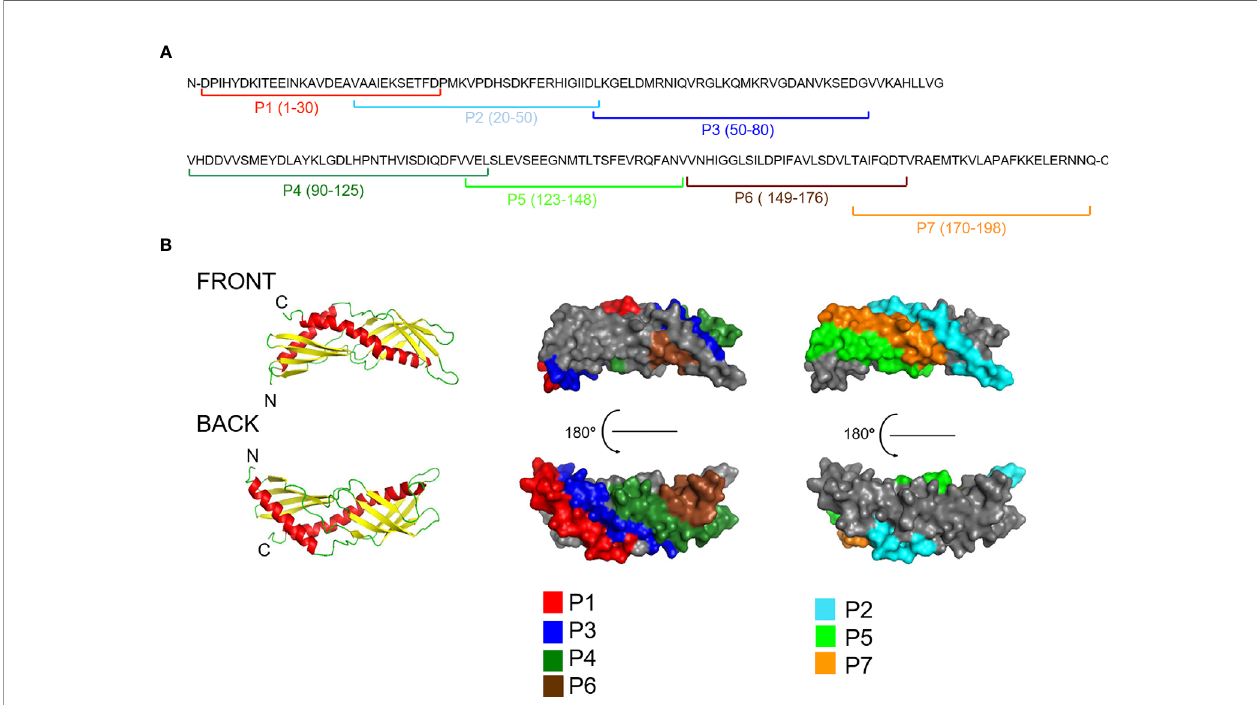
FIGURE 2 | Visualization of peptides spanning the Der p 7 sequence in the Der p 7 structure (A) The position of the peptides is indicated in the Der p 7 amino acid sequence (P1-7). (B) Visualization of the peptides in a model of the 3-dimensional structure of Der p 7 created according to the crystal structure (PDB: 3H4Z). Left images: Ribbon representations of the Der p 7 structure from the front and back. Central and right images: corresponding surface representations of the Der p 7 structure with the peptides highlighted in different colors (P1, red; P2, turquoise; P3, blue; P4, dark green; P5, green; P6, brown; P7,